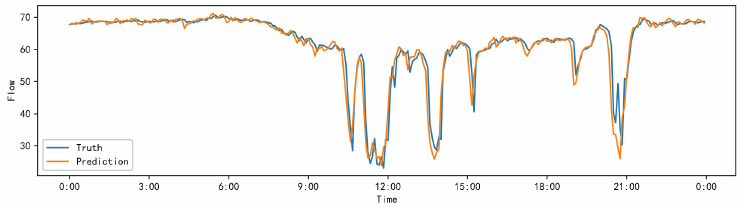
Figure 9. Comparison of the truth value and the predicted value.